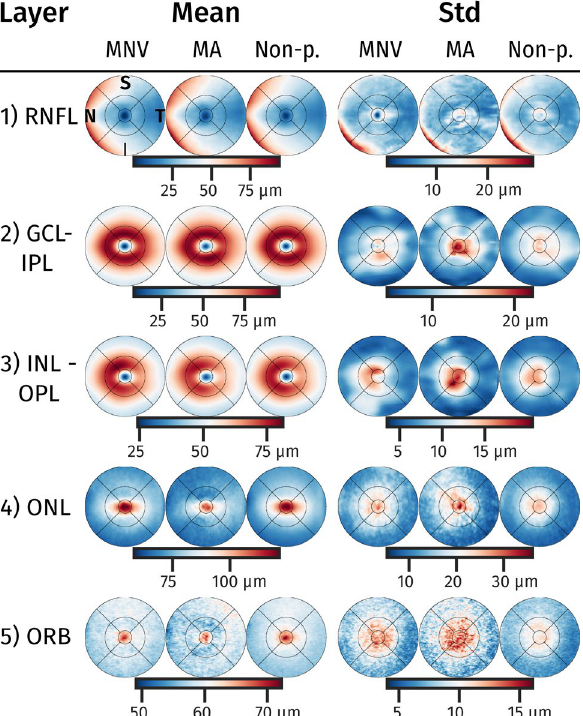
Figure 3. Mean and standard deviation (std) thickness maps of layers. Population mean/std maps within the reference space for the three groups macular neovascularization (MNV), macular atrophy (MA) and non- progressors (Non-p.). For orientation a standard grid with 1,3 and 6mm diameter centred at fovea is shown. Retinal nerve fibre layer (RNFL), ganglion cell layer (GCL), inner plexiform layer (IPL), inner nuclear layer (INL), outer plexiform layer (OPL), outer nuclear layer (ONL), and outer retinal hyperreflective bands (ORB). N (Nasal), S (Superior), T (Temporal), and I